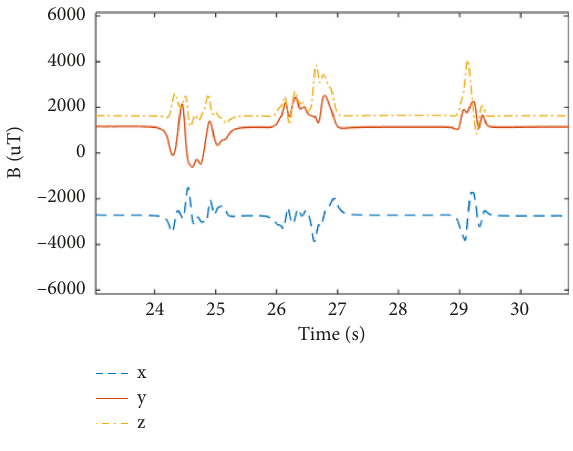
Figure 5: Raw geomagnetic